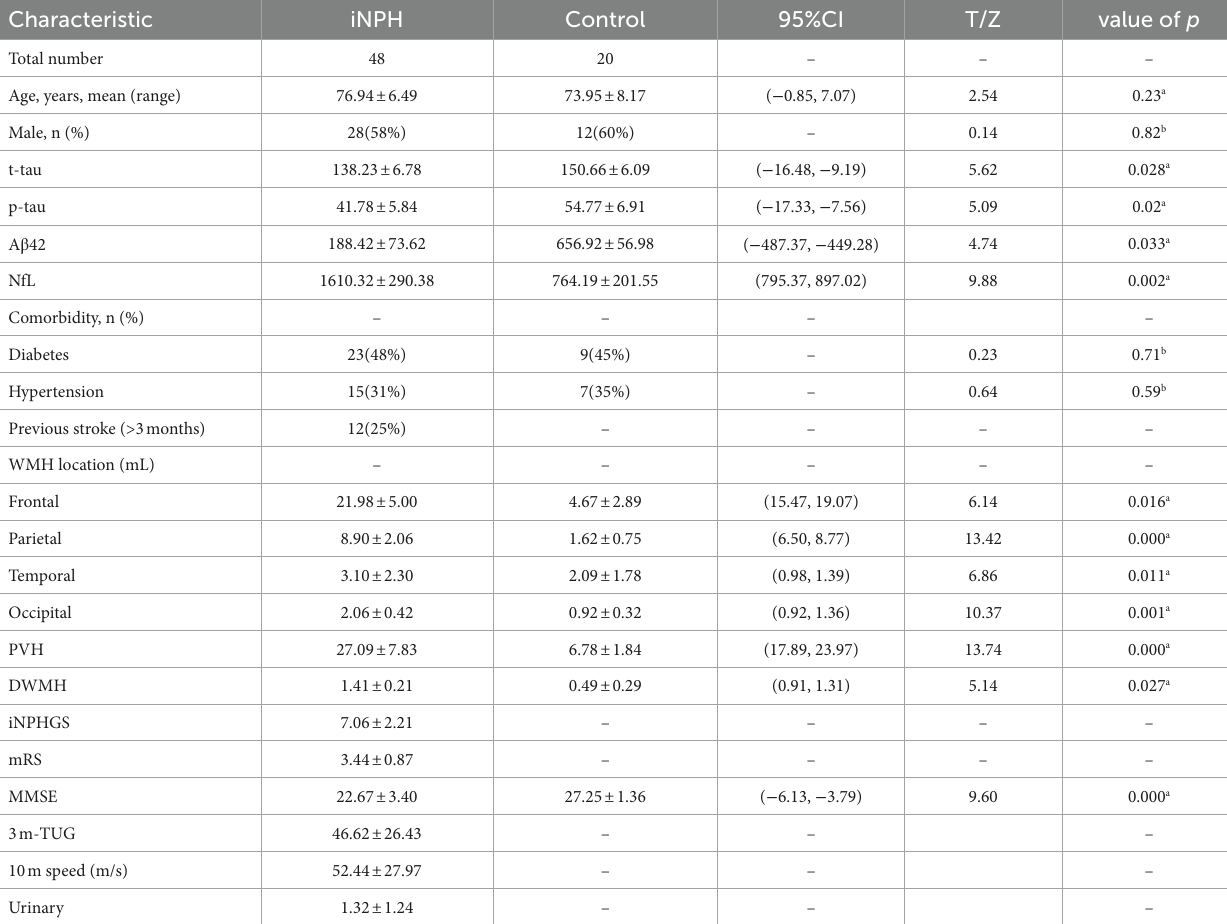
TABLE 1 Demographic data, preoperative symptoms, and protein concentrations. Characteristic